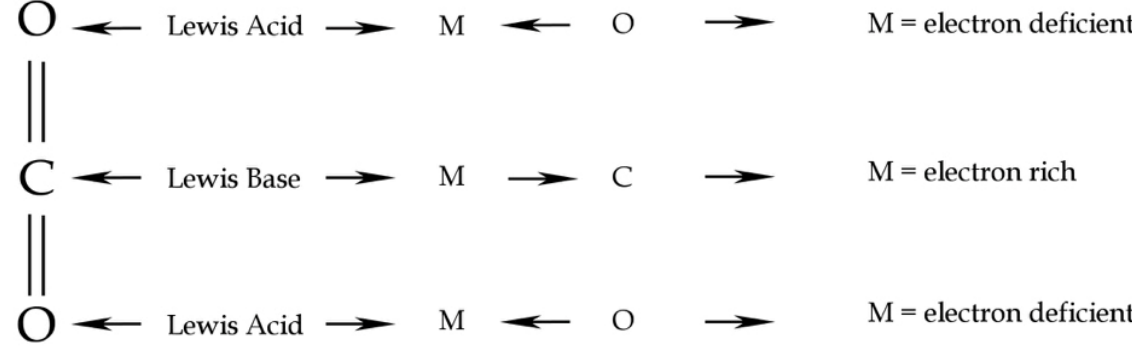
Figure 3. CO 2 Lewis acid/base behaviour. Redrawn from [25].